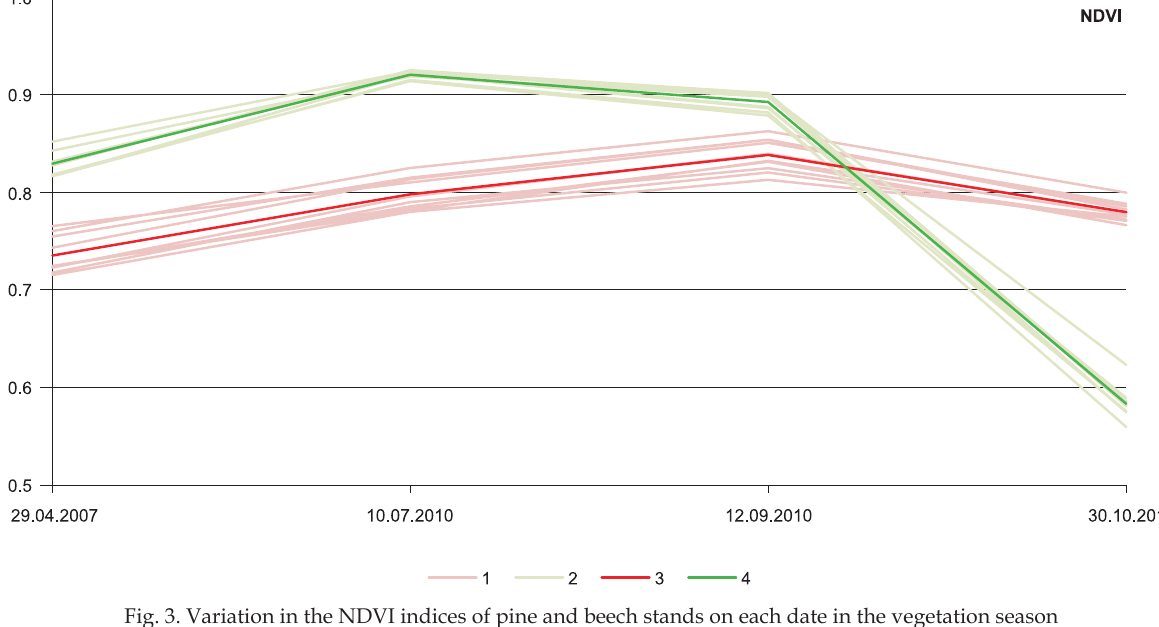
Fig. 3. Variation in the NDVI indices of pine and beech stands on each date in the vegetation season 1 – variation in indices for test areas of pine; 2 – variation in indices for test areas of beech; 3 – average index for pine stand; 4 – average index for beech